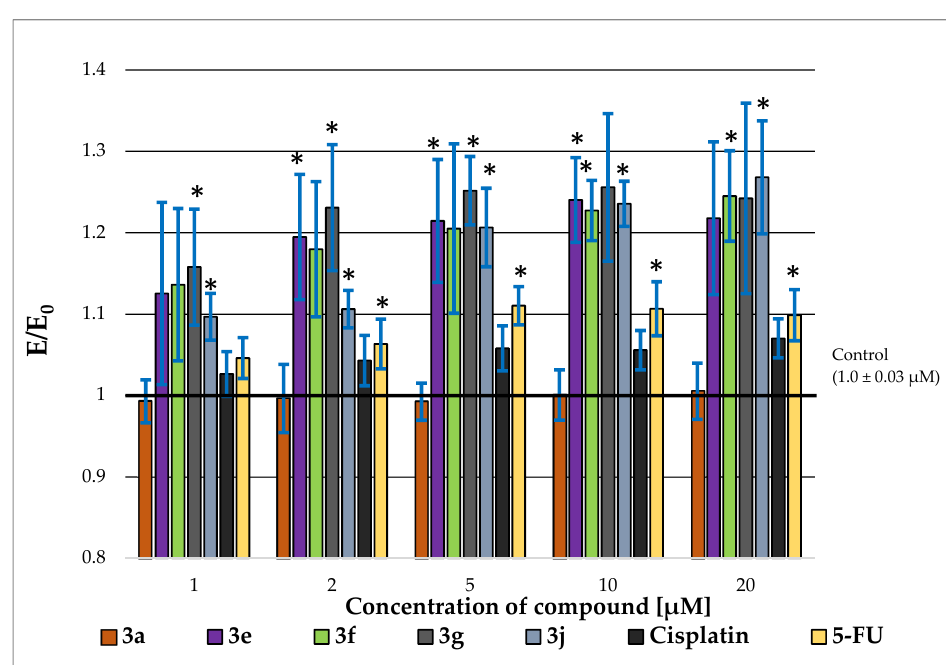
Figure 4. Rhodamine accumulation after incubation with the tested compounds at various concen- tration ranges in HT29 cells; * p < 0.05—significant difference compared to the negative control. E/E 0 —E is the result for the measured sample, and E 0 is the result for the control.